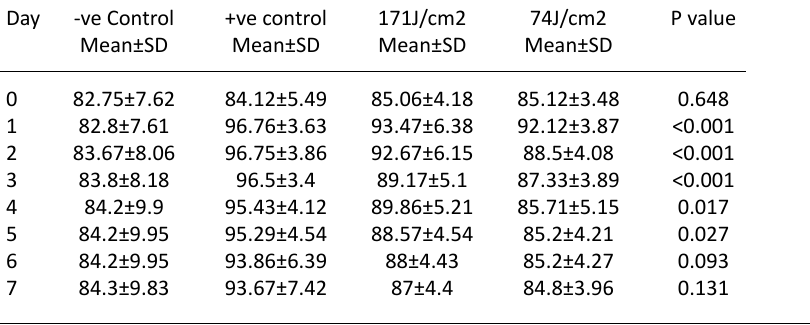
Table 7. Head circumferences comparison among study